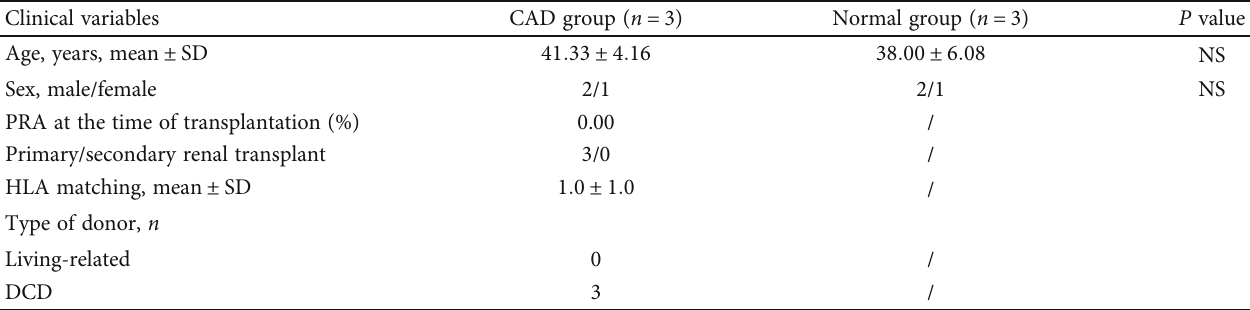
Table 2: Baseline characteristics of the CAD and normal